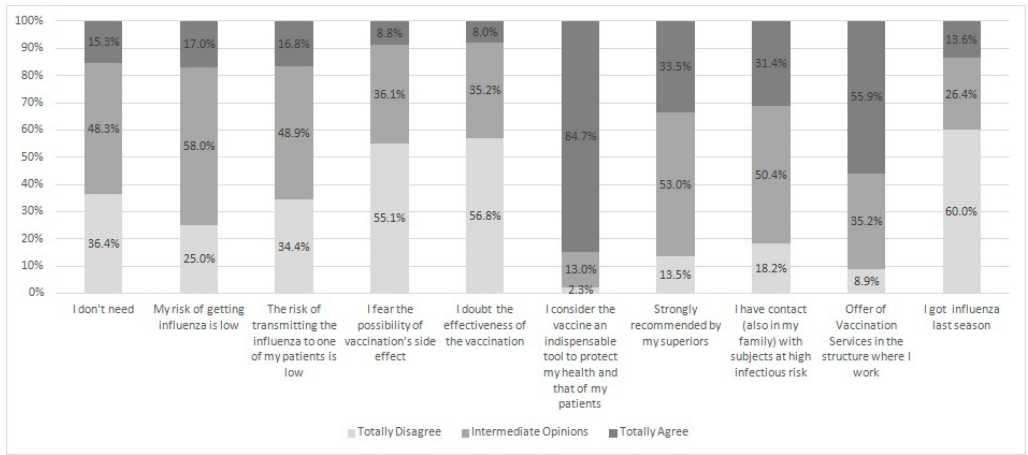
Figure 1. Attitudes of public health professionals (PHPs) (%) about refusing (from first to fifth answer) and adherence (from sixth to tenth answer) to anti-influenza vaccination.